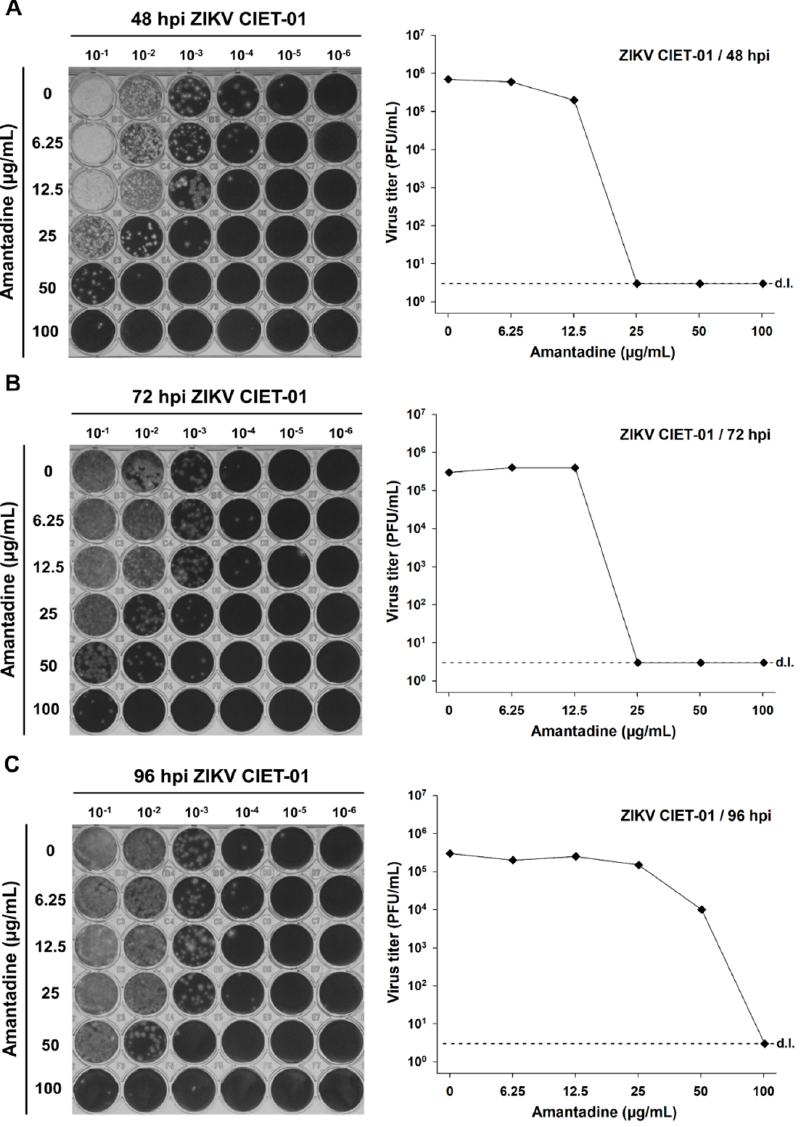
Figure 1. Amantadine hydrochloride suppresses the in vitro replication of a ZIKV clinical isolate. Virion production was quantified by plaque assays of culture supernatants of Vero cells treated with different concentrations of amantadine hydrochloride at 48 ( A ), 72 ( B ), and 96 ( C ) hours post-infection (hpi) with ZIKV clinical isolate CIET-01 at an MOI of 0.1. Data from a single experiment are shown. d.l. = assay detection